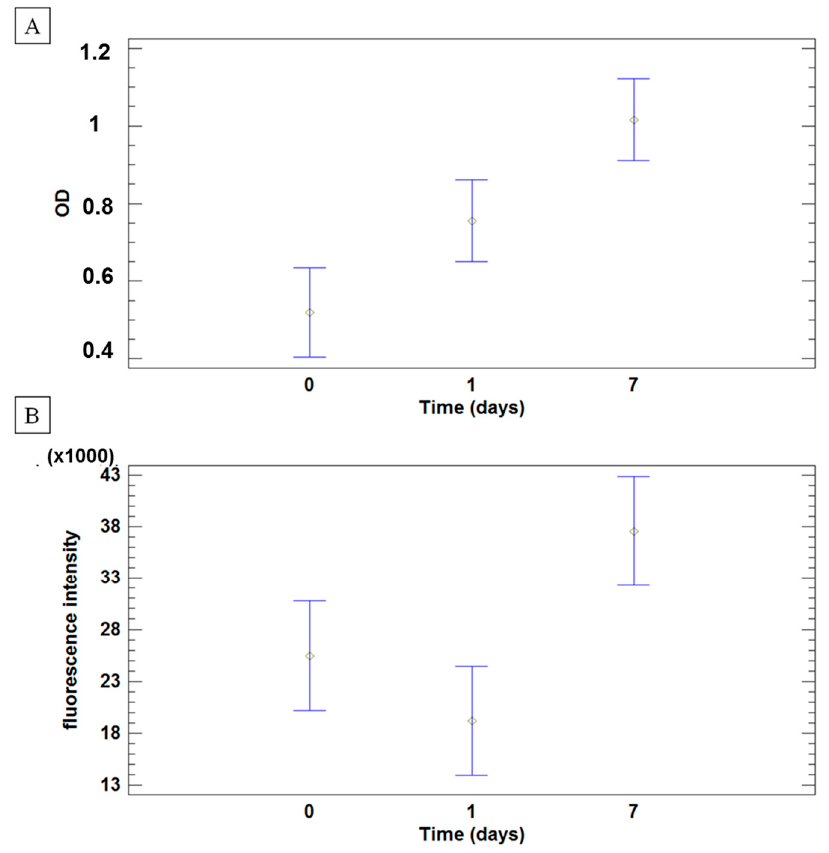
Figure 8. hASCs metabolic activity, performed by MTT (3-(4,5-Dimethylthiazol-2-yl)-2,5-diphenyltetrazolium bromide) ( A ) and Alamar Blue ( B ) assays. Results are reported as mean values and 95.0% least significance difference (LSD) intervals of optical density ( A ) and fluorescence emission ( B ) of hASCs cultured on FAMs after 7 days of culture